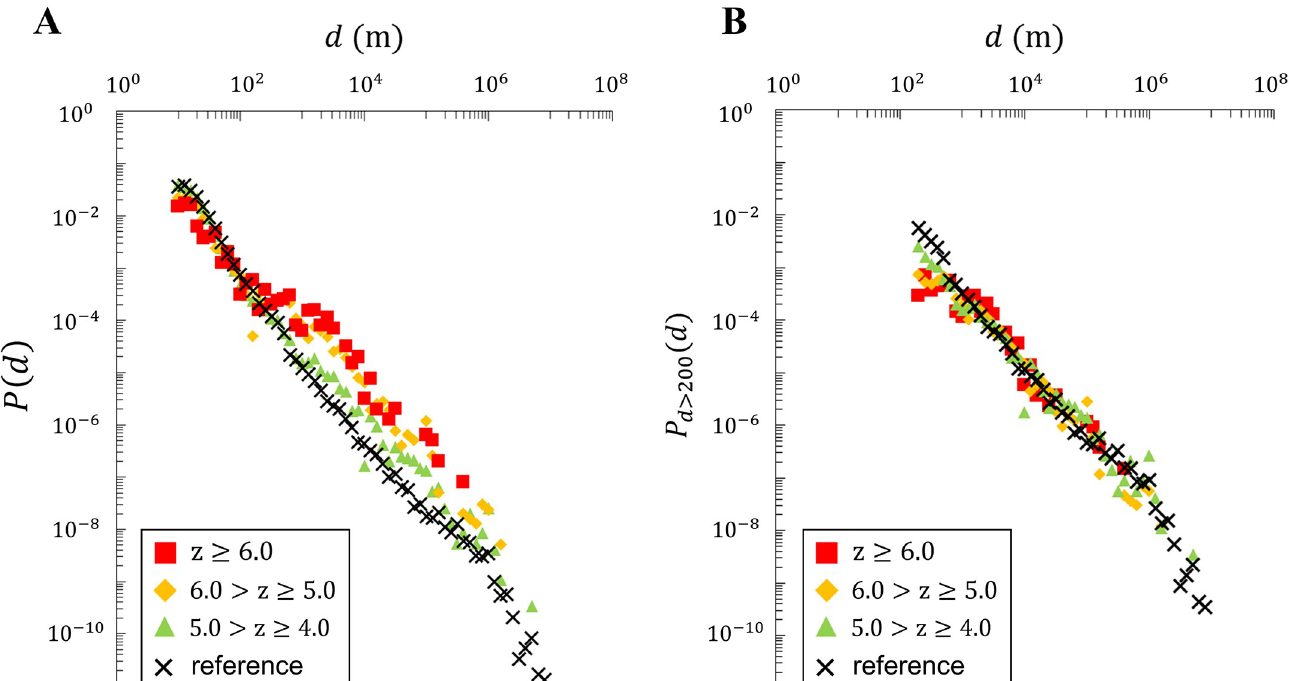
Fig 4. Distribution of evacuation distance. A: distribution of evacuation distances including all observed users. B: distribution of evacuation distances for only those who evacuated. We can observe that the probability densities for different seismic intensities collapse into one distribution, implying that evacuation distances are not dependent on seismic